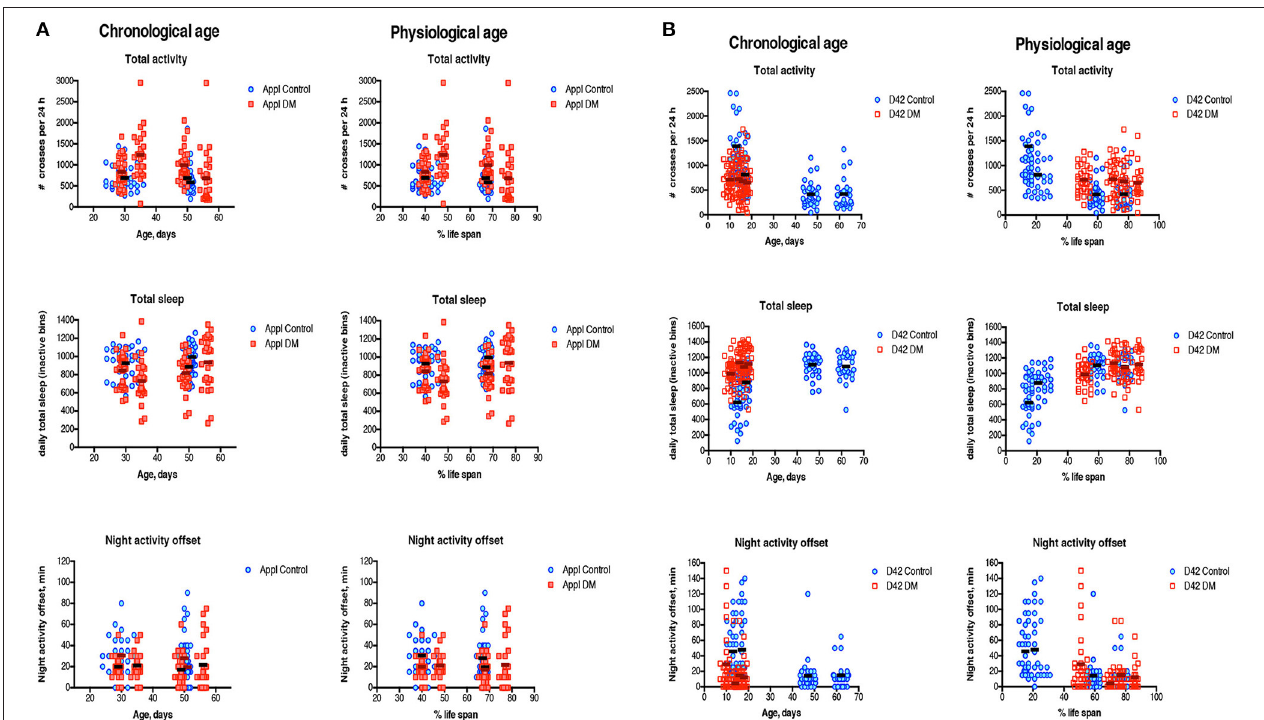
FIGURE 4 | Sleep-wake behavior of single fly. Measures of daily total activity, daily total sleep and night activity offset in the DM obtained with Appl-Gal4 driver (A) and D42-Gal4 driver (B) and corresponding Controls have been done in male flies at different ages as indicated in Supplementary Table 3 . Data are scaled to both chronological age and physiological age. All measurements were performed at Zeitgeber time 0 (ZT0), the time when the lights go “on.” Results are represented for each single measurement of two experiments with independent cohorts with mean values. The abbreviations and genotype of flies are described in Table 1 . To evaluate the difference in age-dependent changes in sleep-wake behavior parameters between Control and DM lines, regression curve slopes and intercepts were compared ( Table 4 ).